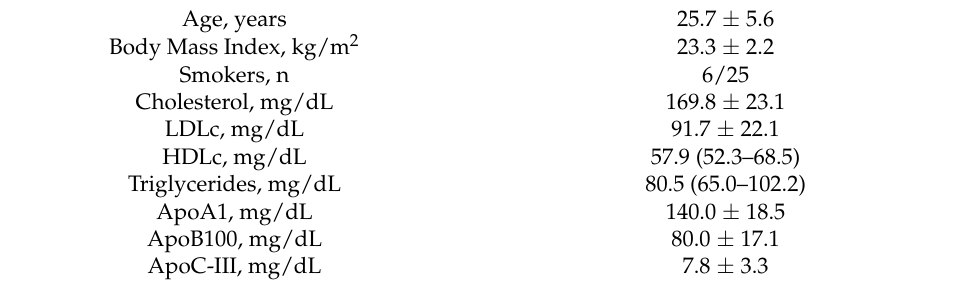
Table 1. Characteristics of the study population.